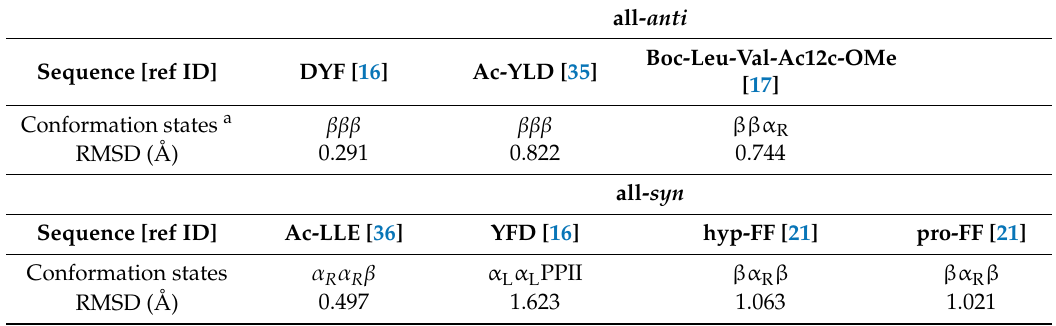
Table 1. Similarity between conformations sampled in this study and those seen in the crystal structures of assembling tripeptides reported in previous experimental